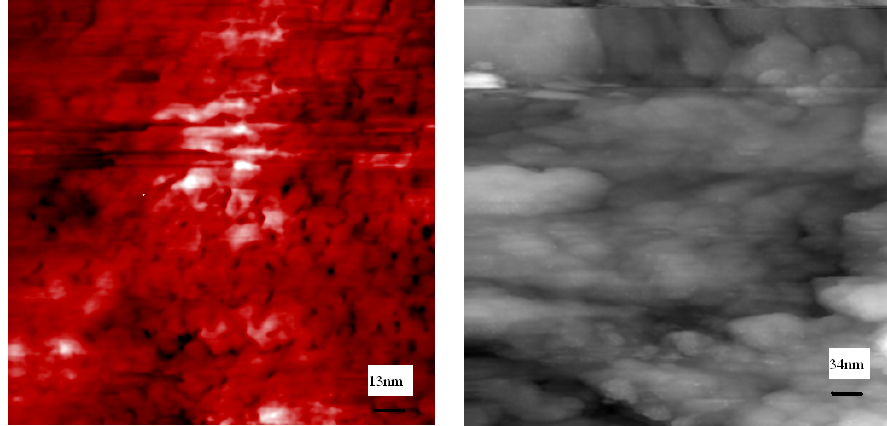
Fig. 1. Images of nanosized TiO